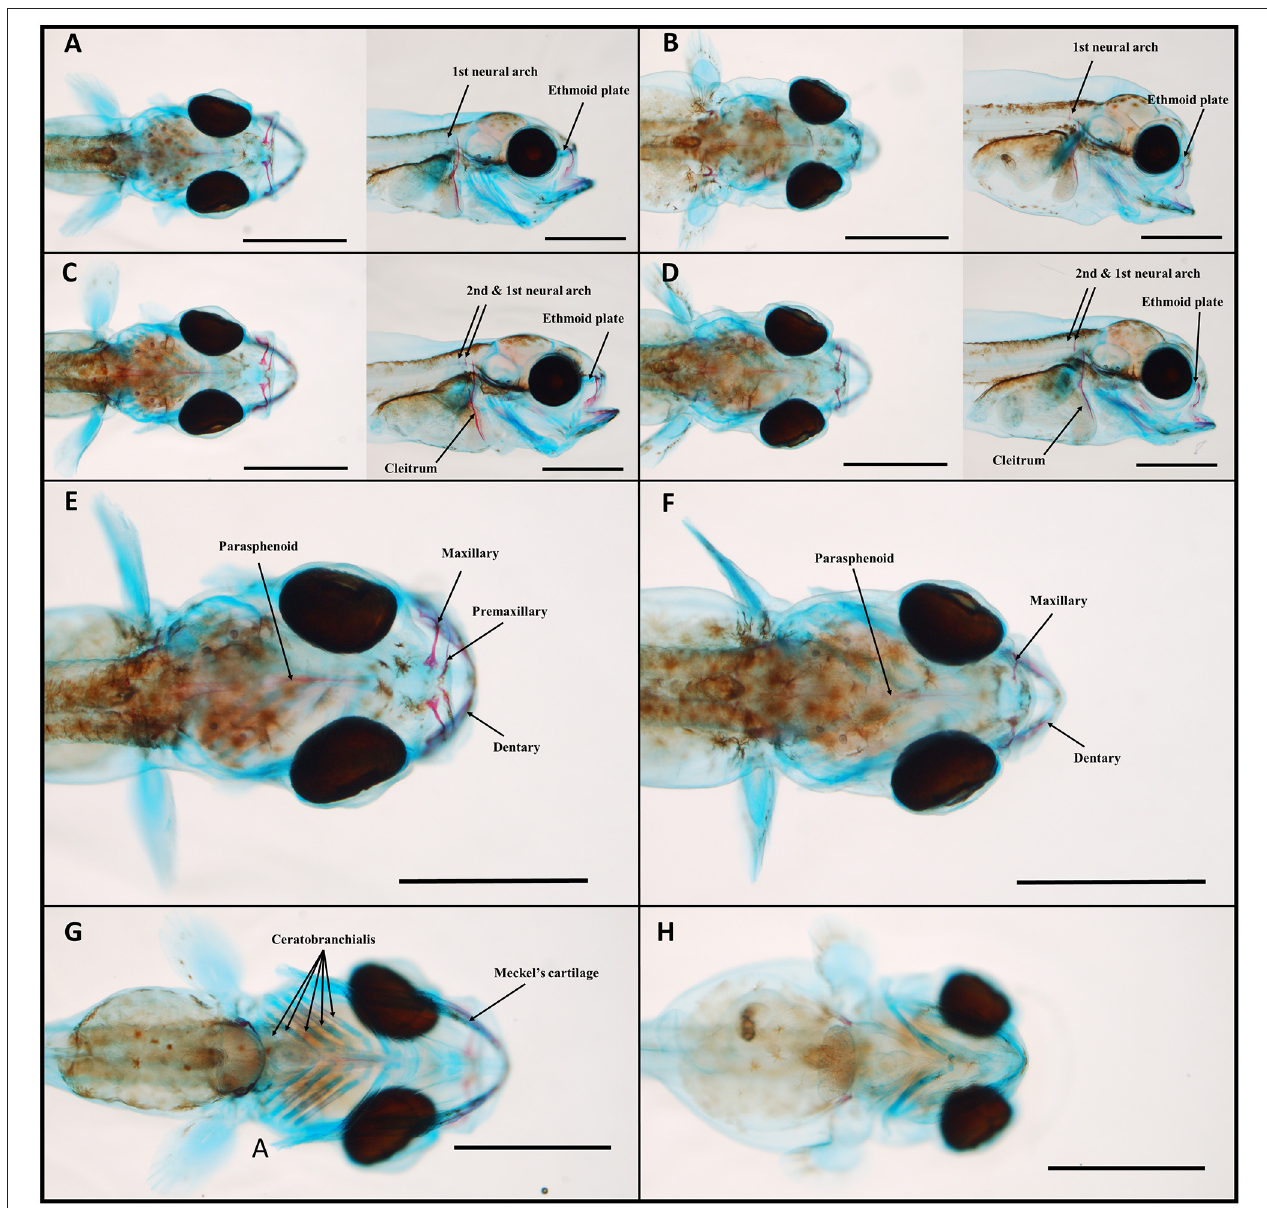
FIGURE 4 | Control (A,C,E,G) and crude oil-exposed (B,D,F,H) 19-dph haddock larvae of equal standard-length stained with Alizarin red and Alcian blue. At 19 dph, ossification of the second neural arch has started in the larger larvae (C,D) , 6.7 and 6.6mm, respectively. Onset of the parasphenoid can be seen in all the larvae. When comparing larvae of similar length, the premaxillary was only observed in the control group (E,F) , dorsal view. Branchial arches were also severely compressed in the exposed larvae (H) , ventral view in comparison with the control larvae (G) , ventral view. Scale bars: